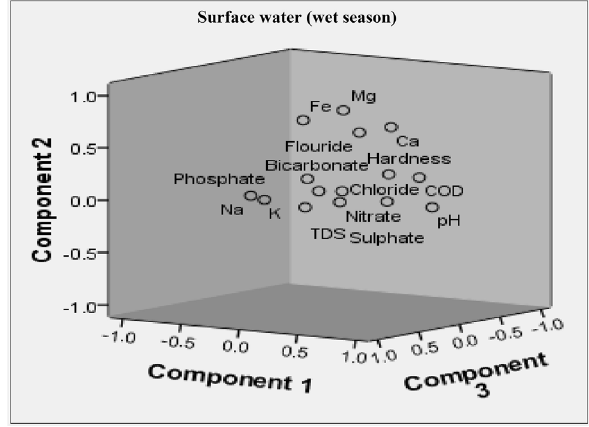
Fig. 5 Principal component analysis (PCA) for the selected SW sources in the wet